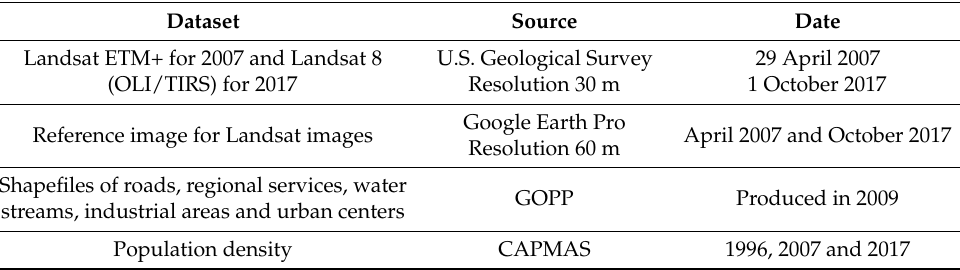
Table 2. Dataset types and sources.